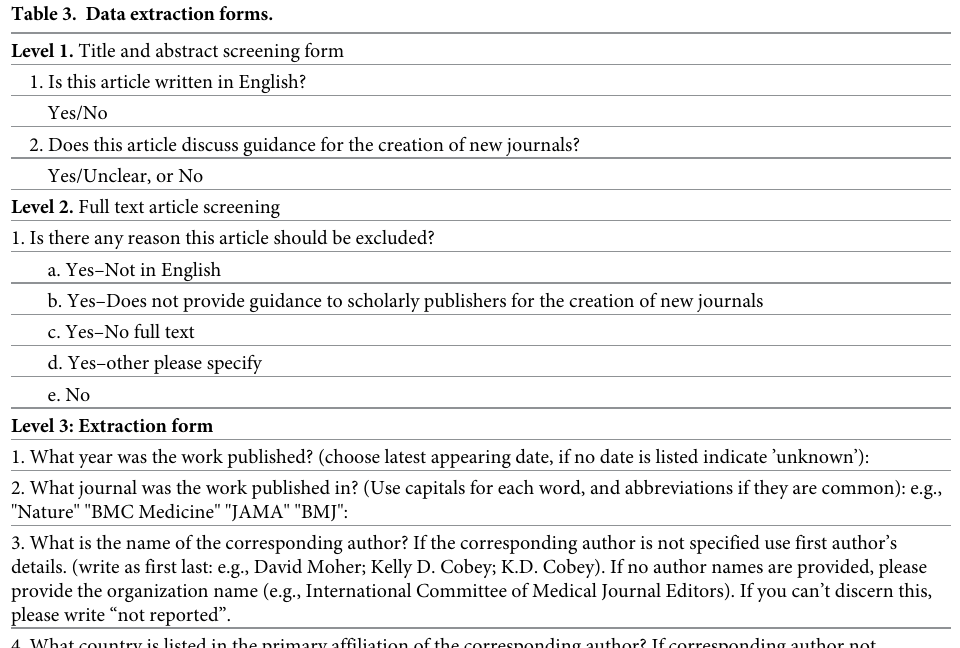
Table 3. Data extraction